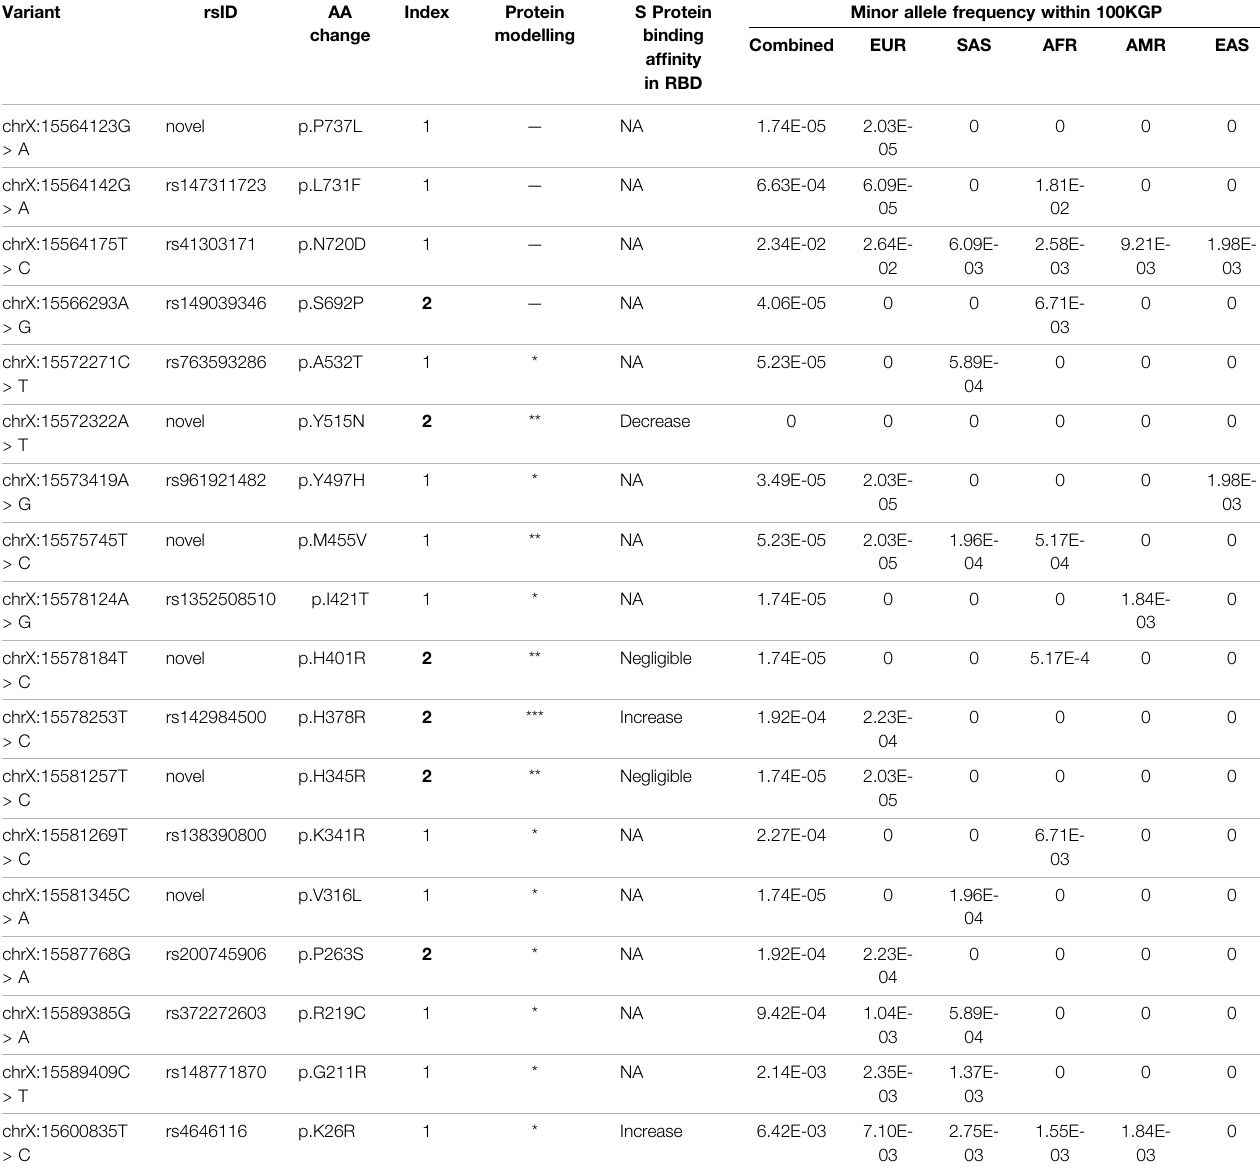
TABLE 1 | Characterisation of nonsynonymous ACE2 variants in SARS-CoV-2 patients. Intronic, intergenic and synonymous variants are considered non-pathogenic and thereforeexcludedfromthelist.Theindexscoreisbasedonthetypeofvariant,theREVELscore,andtheGERP++score.Anindexscoreof1signi fi esanonsynonymous variantwithacorrespondingREVELscore < 0.5,suggestinglowpathogenicity.Anindexscoreof2indicatesanonsynonymousvariantwithaREVELscoreof > 0.5,GERP++ score > 2,CADDscoreof > 20andPolyPhen2predictionoutcomeof “ probablydamaging ” ,suggestinghighpathogenicity.Sixvariantswerenotreportedinpublicdatabases (p.V316L,p.H345R,p.H401R,p.M455V,p.P737L,p.Y515N).Deepmutagenesisexperimentaldatashowp.K26R,p.H378Randp.Y515Nalteredbindingaf fi nitywithS protein (Chan et al., 2020). This is consistent with our protein interaction analysis. Mutations are ranked according to their potential to affect protein stability and activity, denoted by asterisks (* = low, ** = medium, *** =